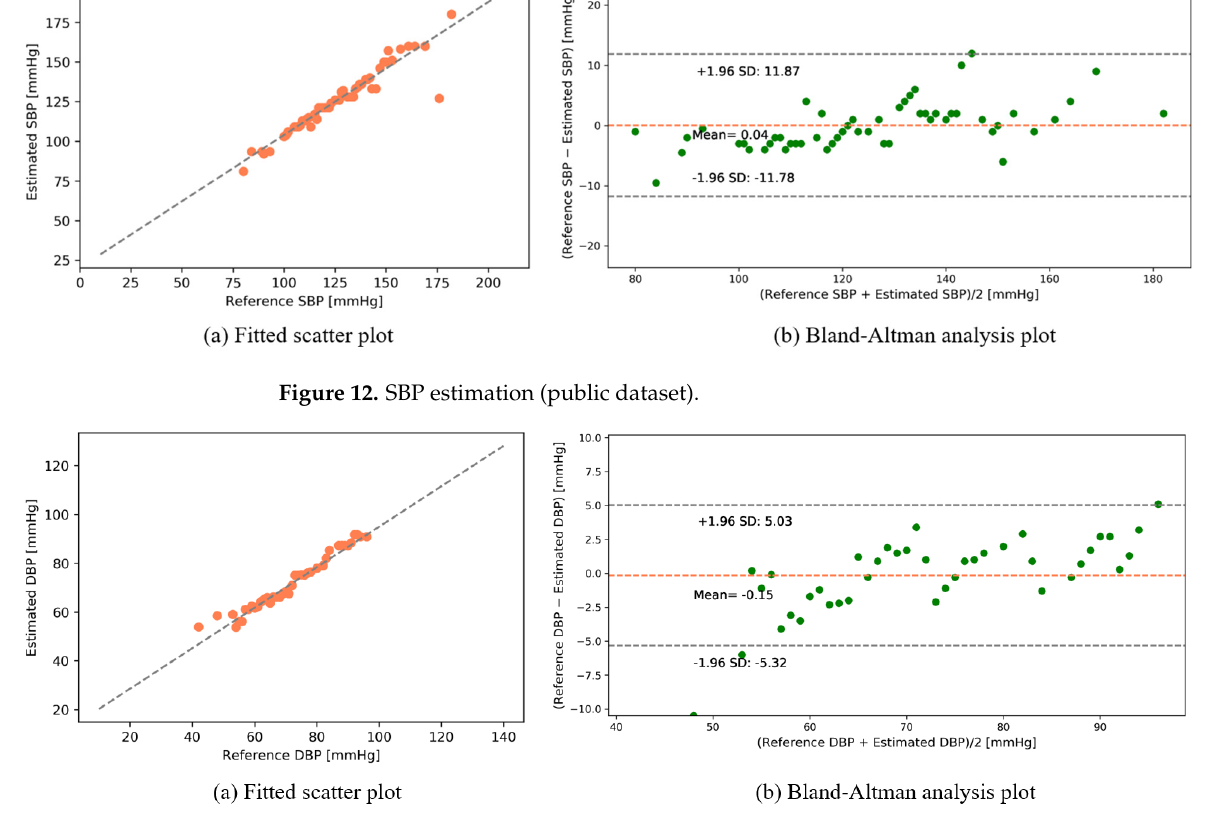
Figure 13. DBP estimation (public dataset).